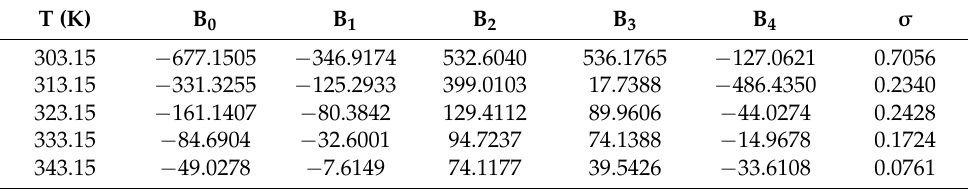
Table 5. The fitting parameters ( B P ) and the standard deviation ( σ ) of Equations (3) and (4)